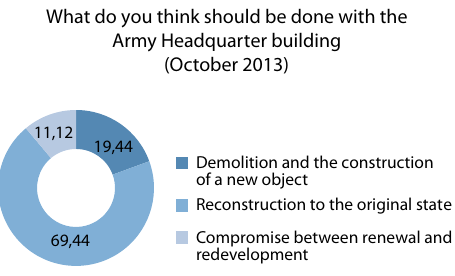
fig. 6. The result of the small-scale opinion poll, conducted